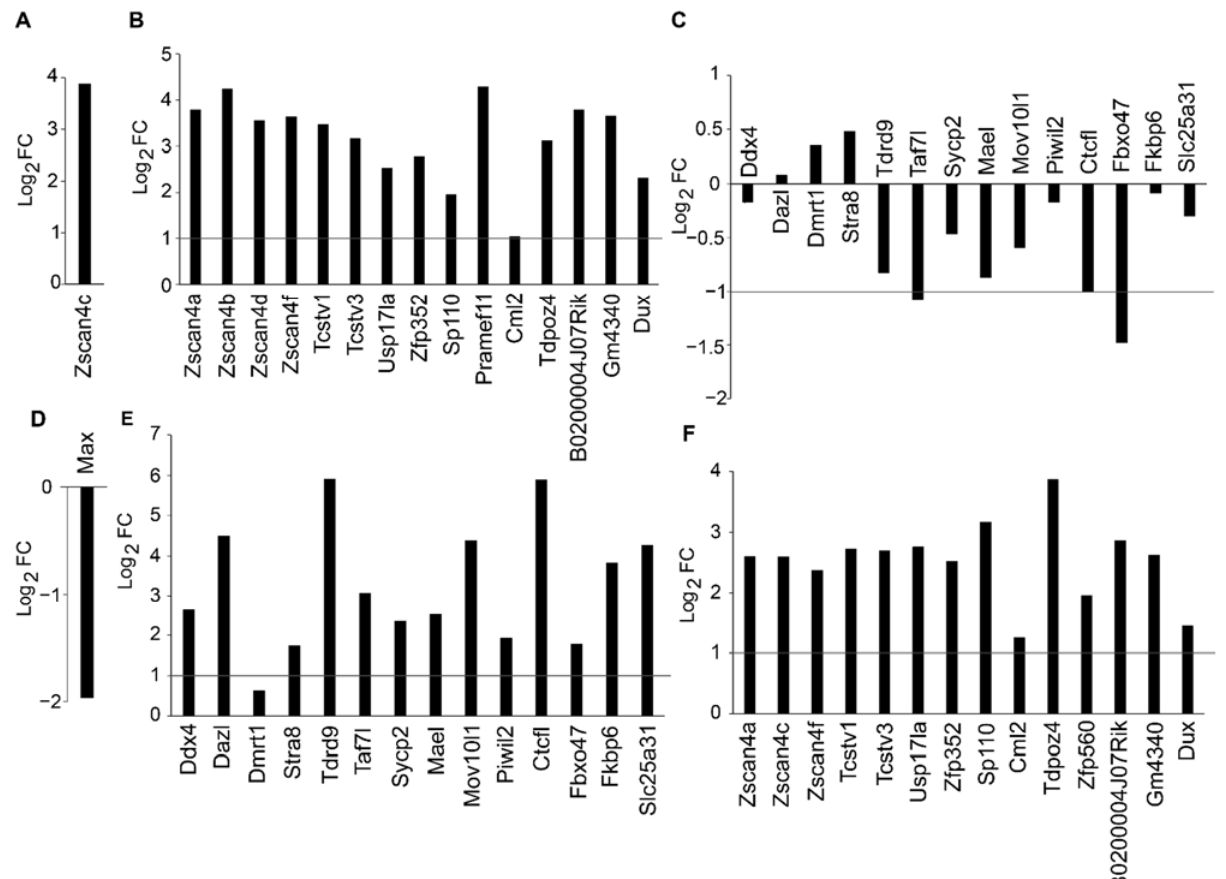
Figure 4. Sequential activation of germline genes and ZGA genes. ( A – C ) Analysis of public RNA-seq data (GSE120998) for Zscan4c overexpression ( A ); ZGA gene expression change ( B ); germline gene expression change ( C ). ( D – F ) Analysis of public microarray data (GSE45181) for Max downregulation ( D ); germline gene expression change ( E ); ZGA gene expression change ( F ).